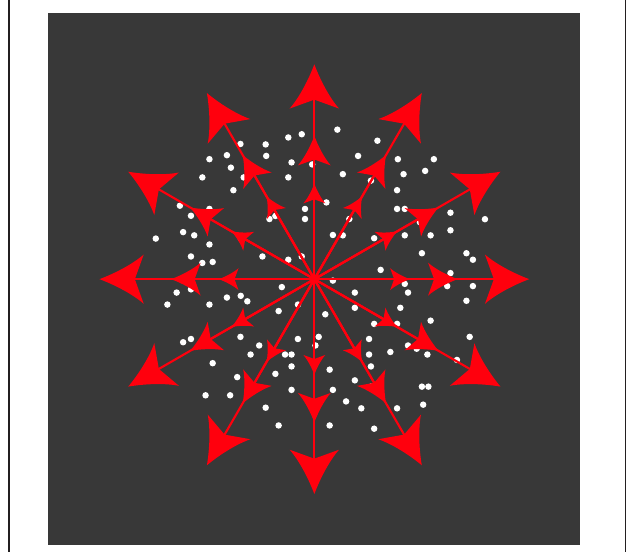
FIGURE 2 | The constraint line stimulus consisted of light dots inside a circular aperture on a dark background. Per trial, the dots moved within the aperture in one of 12 or 8 evenly spaced directions and at one of a range of at least five different speeds. The stimulus was positioned concentrically with the receptive field of an MT cell or on a responsive area within an MST receptive